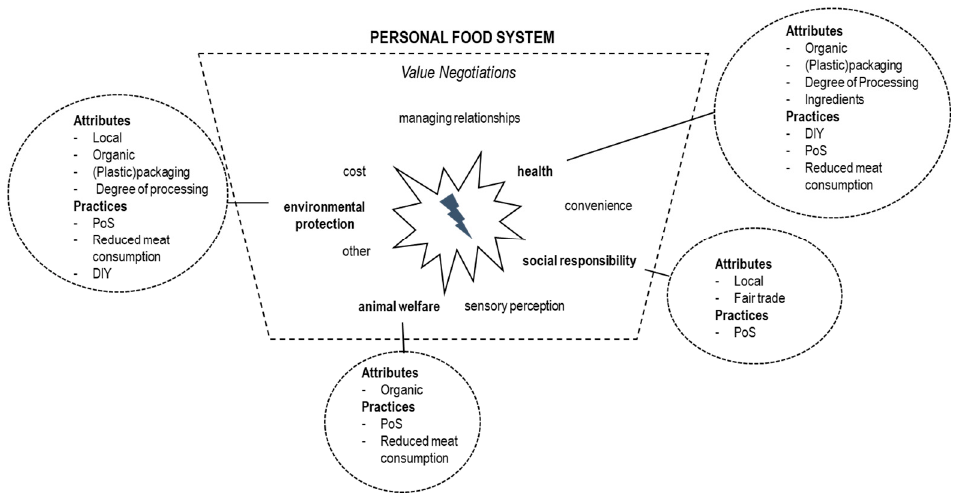
Figure 4. Attributes and practices participants associated with sustainability values.